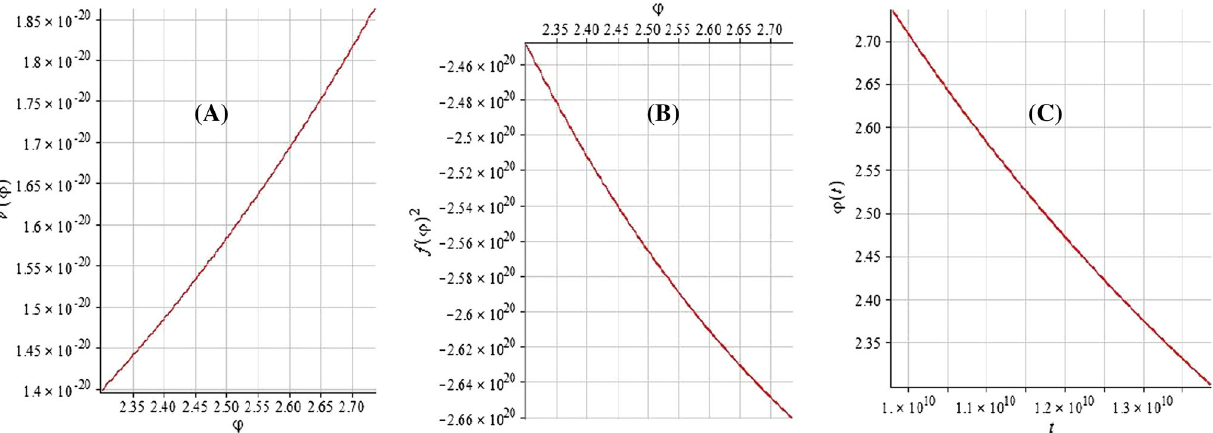
Fig. 6 Plots a and b indicate the scalar potential V (φ) and coupling function f 2 (φ) versus scalar field φ at the time evolving range [9.8Gyr, 13.8Gyr], respectively, while plot c shows the scalar field φ versus time at the same time